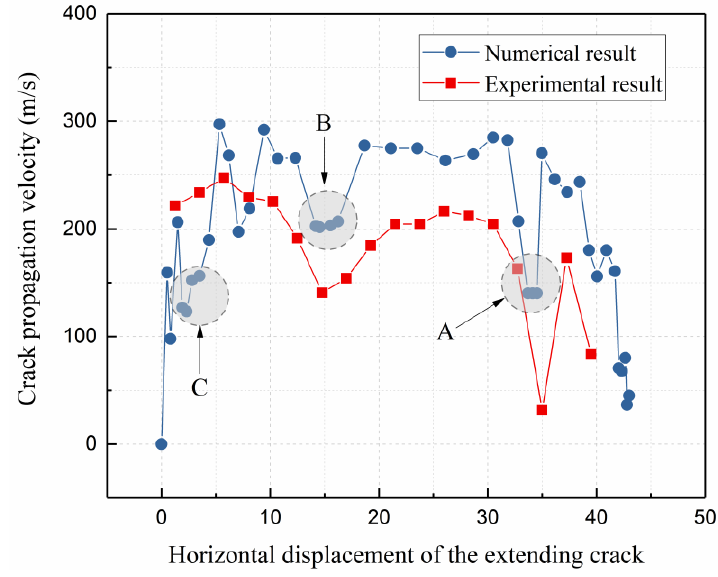
Figure 13. Crack propagation velocity of the numerical (AUTODYN) and experimental result.